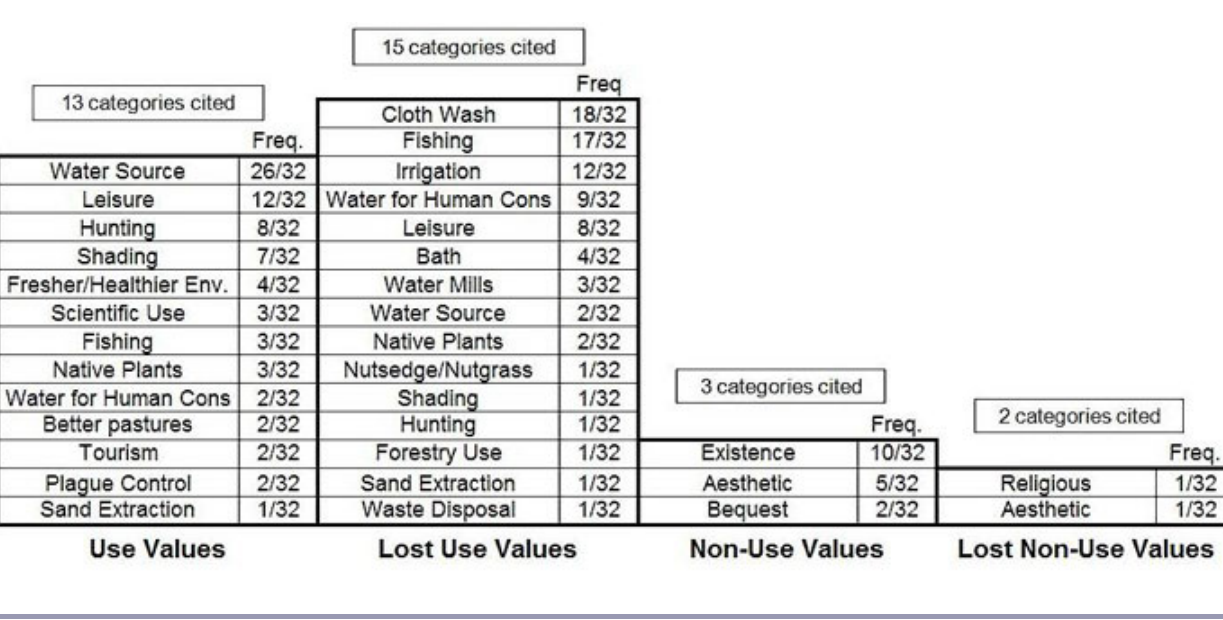
Fig. 2. Categories of use values, lost use values, non-use values, and lost non-use values of the streams identified by the 32 landholders and corresponding frequency of value category being cited among the 32